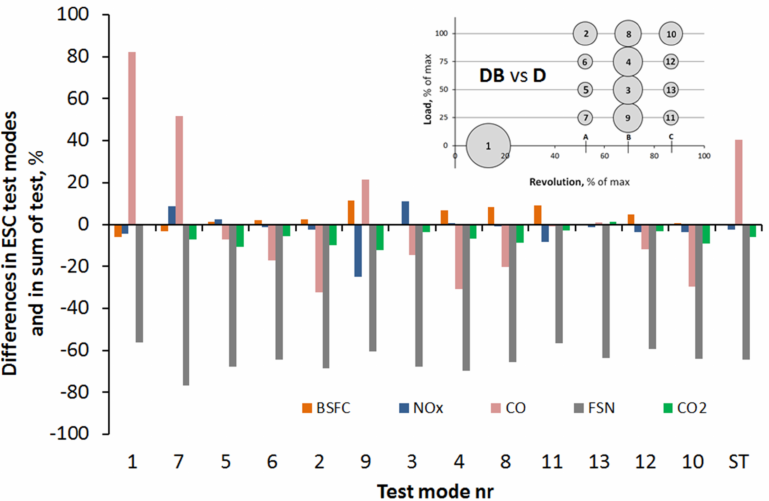
Figure 8. Differences in averages by feeding the engine with DB vs. feeding with D fuel (in